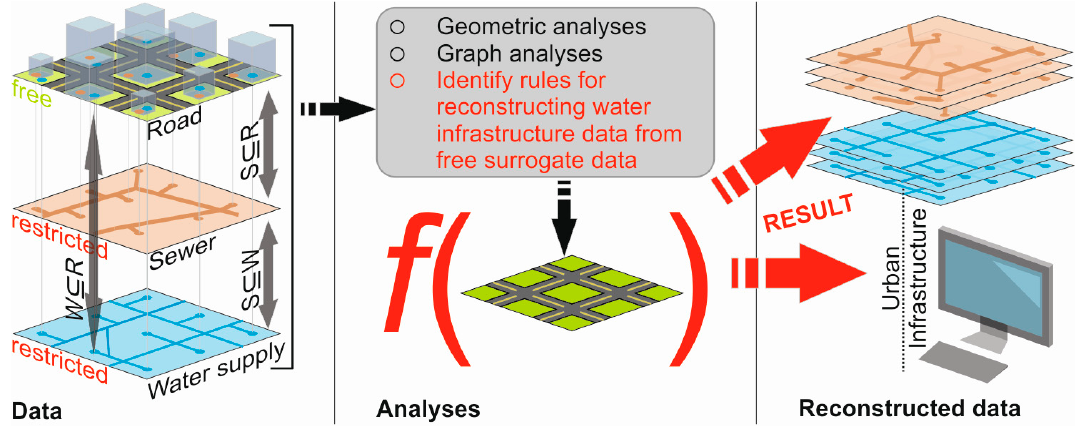
Figure 1. Proposed approach to use surrogate information for network (re ‐ )construction.